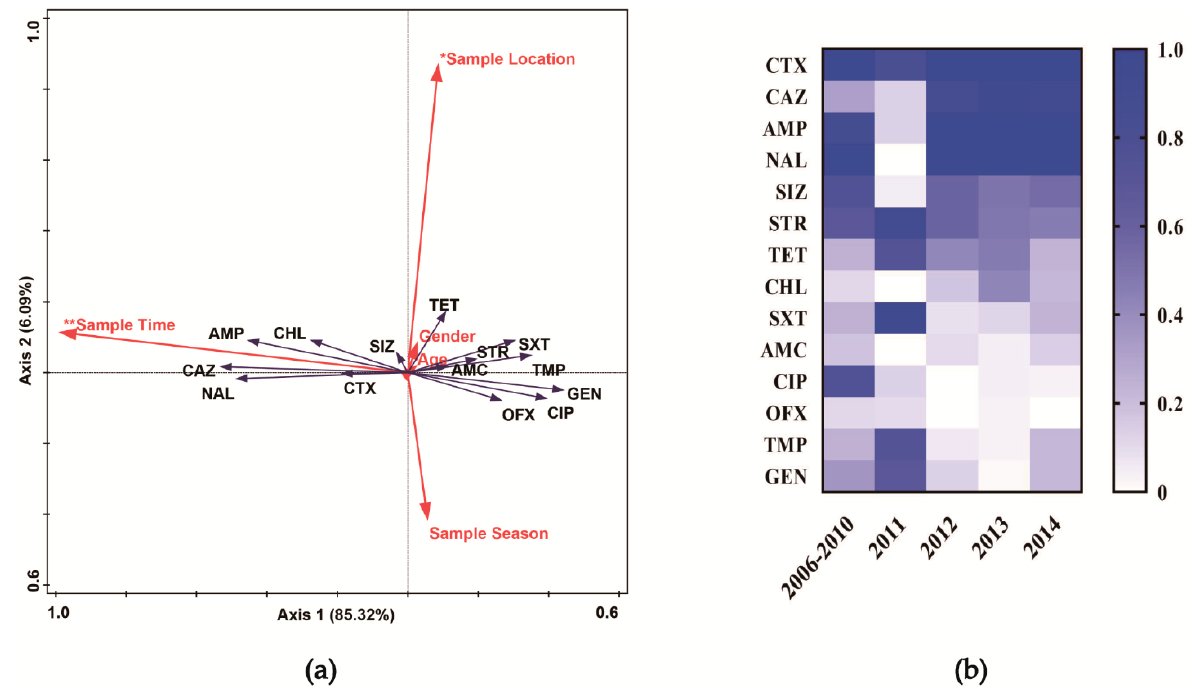
Figure 2. ( a ) Biplot of the redundancy analysis depicting the relationship between antibiotic resistance rates of S. Enteritidis isolates and sampling time, location, season, and patient gender and age ( n = 292). * p < 0.05; ** p < 0.01 (by Mantel test). ( b ) Antibiotic resistance rates of S. Enteritidis isolates recovered from clinical samples in Shanghai, 2006–2014 ( n = 292). CTX: Cefotaxime; CAZ: Ceftazidime; TET: Tetracycline; AMC: Amoxicillin-Clavulanic acid; AMP: Ampicillin; CIP: